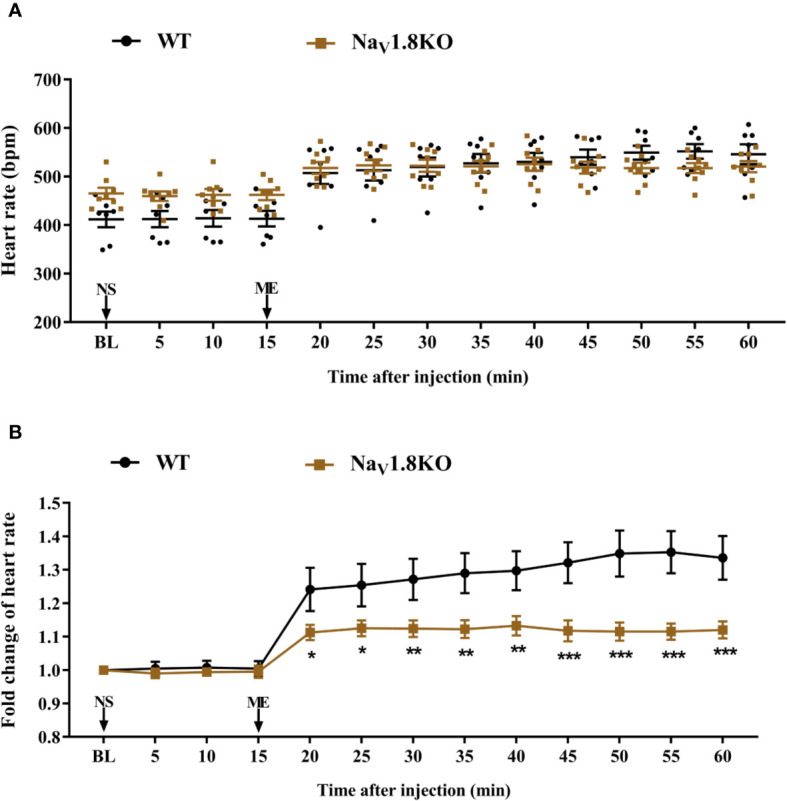
The heart rate response of methoctramine in NaV1.8 knockout mice. (A) Scatter diagram of heart rate after methoctramine application. (B) Line diagram of fold change of heart rate after methoctramine treatment. Heart rate was normalized to the value of baseline heart rate for each group. *p < 0.05, **p < 0.01, ***p < 0.001 vs wild type mice. WT, wild type; KO, knock out; NS, normal saline; ME, methoctramine; BL, baseline.